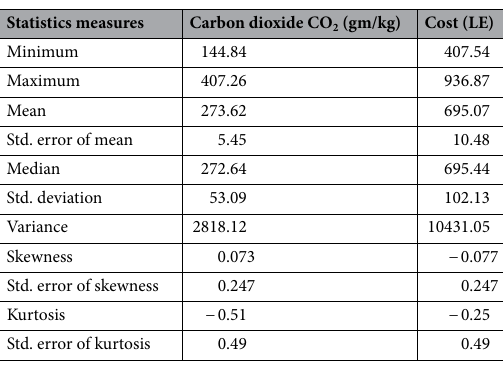
Table 7. Statistics of the CO 2 and cost